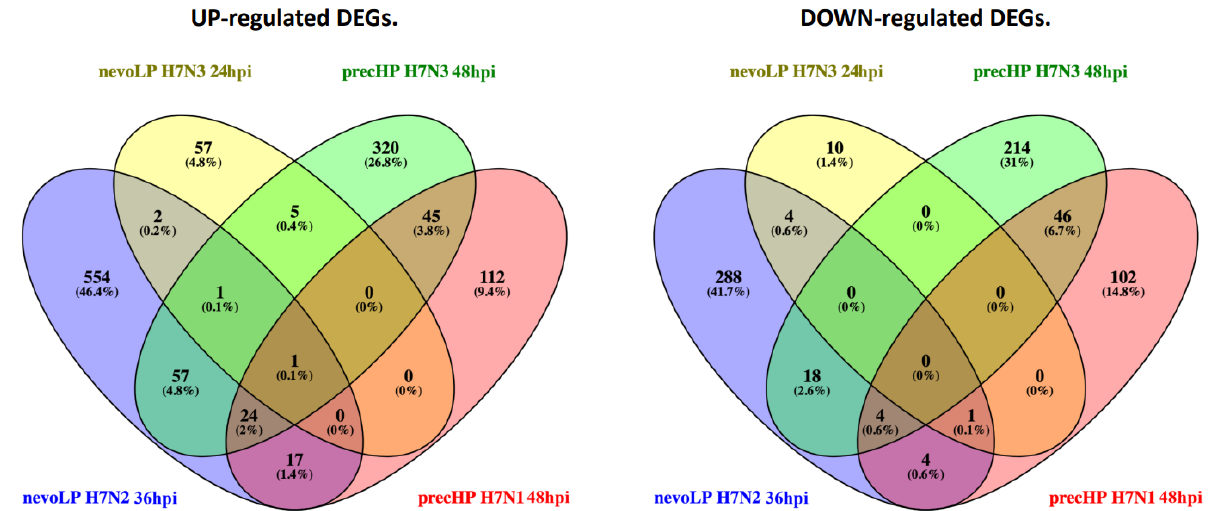
Figure 3. Venn diagram showing the common and specific differentially expressed genes (DEGs) between the important timepoints of different viruses. DEGs are split between up- and downregulated